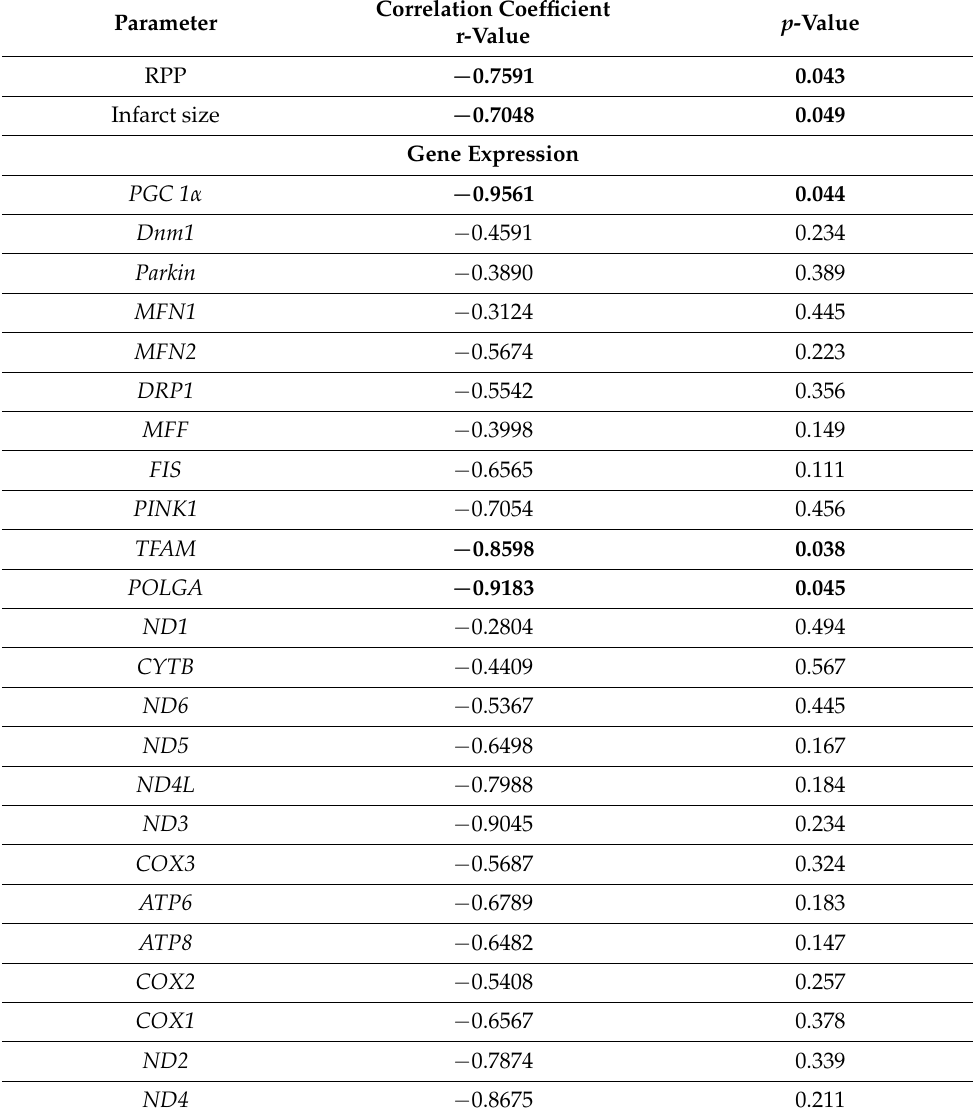
Table 3. Correlation data of global DNA methylation with the injury and mitochondrial function during cardiac I/R in diabetic rats: Pearson correlation analysis of global DNA methylation with the cardiac injury and hemodynamic parameters and the mitochondrial